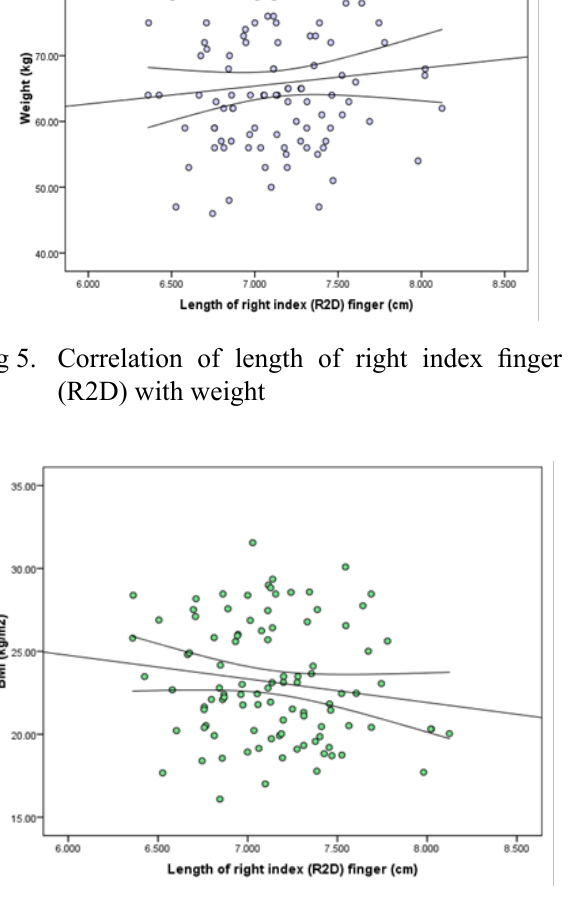
Fig 7. Correlation of length of right index finger (R2D) with BMI